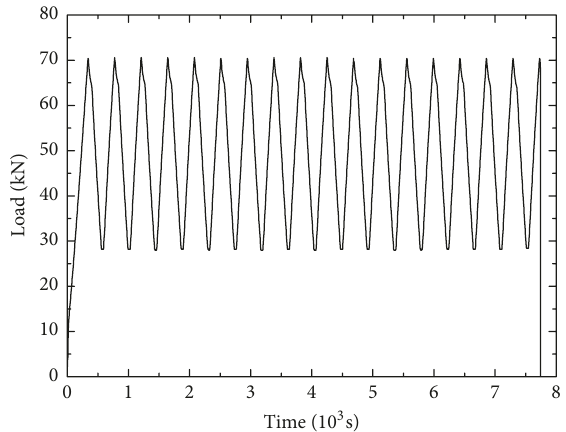
Figure 4: Curve of load and